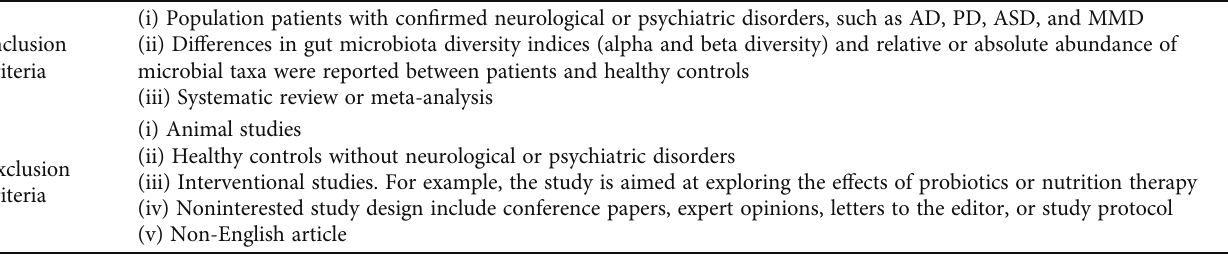
Table 1: Inclusion and exclusion according to criteria.